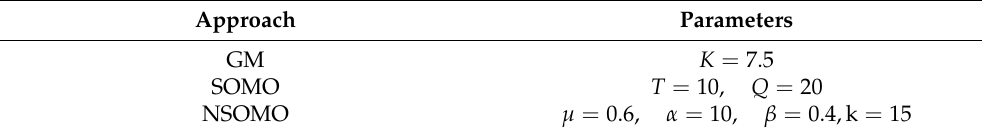
Table 1. Parameters of three observers.